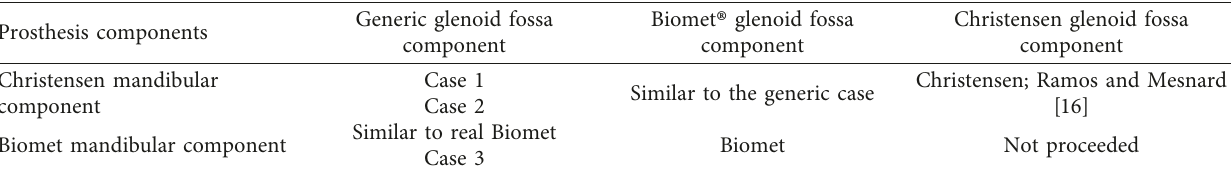
Figure 2: From DICOM to CAD: (a) the patient’s computerized axial tomography (CAT) cut by a horizontal plane and (b) final configuration of the selected geometry in Abaqus ® . Table 1: Cases of the study considered for the